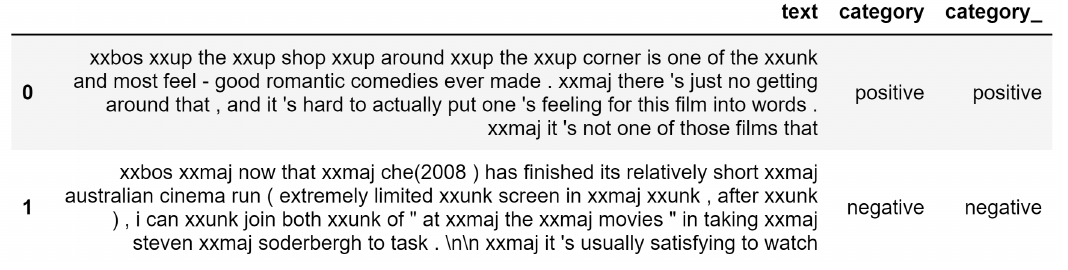
Figure 7. In text classification, results are displayed in a DataFrame with the tokenized